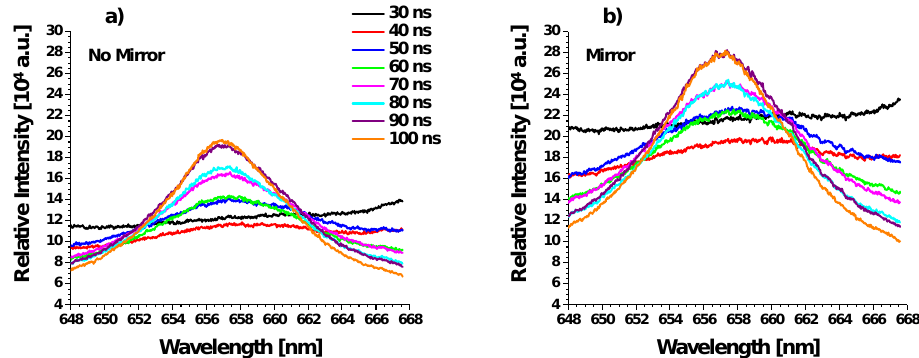
Figure 3. Temporal development of the H α line in the first 100 ns following plasma initiation. ( a ) Measured spectra and ( b ) spectra measured with its duplication.